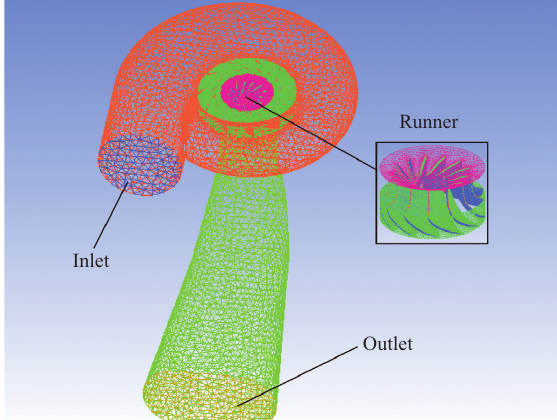
Figure 7: Mesh results of the turbine